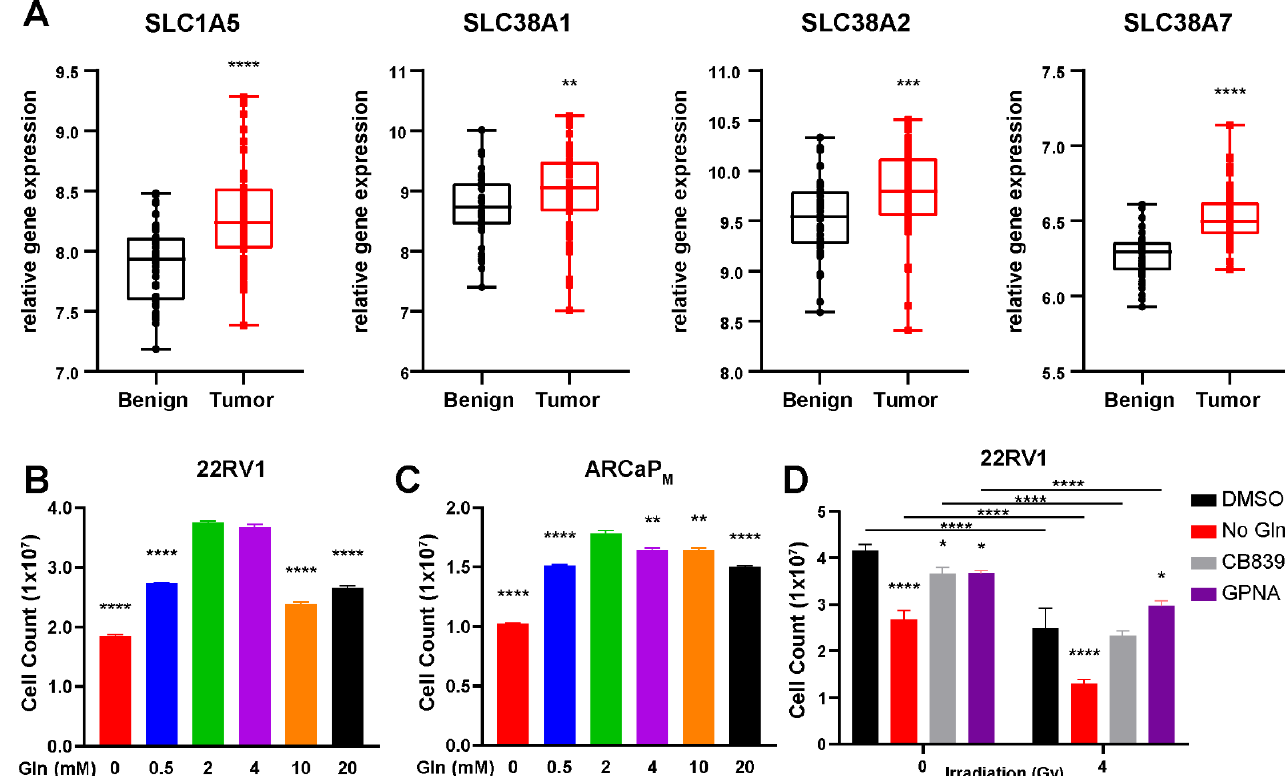
Figure 1. Glutamine is a conditionally essential amino acid for prostate cancer. ( A ) Fold change of SLC1A5, SLC38A1, SLC38A2, and SLC38A7 in benign and prostate cancer patients in the gse29079 data set, obtained from R2-Genomics analysis ( n = 95). ( B ) 22RV1 cells were counted 72 h after culturing in media containing the indicated concentrations of glutamine (L-Gln). ( C ) ARCaP M cells were counted 72 h after culturing in media containing the indicated concentrations of L-Gln. ( D ) 22RV1 were irradiated (4 Gy) and counted 72 h after culturing in media containing L-Gln (0 or 2 mM), with and without administration of GPNA (100 µM) or CB839 (1 µM). Cell counts are reported as a mean ± SD of at least three biologic replicates (* p < 0.05, ** p < 0.01, *** p < 0.001, **** p < 0.0001, compared to control).